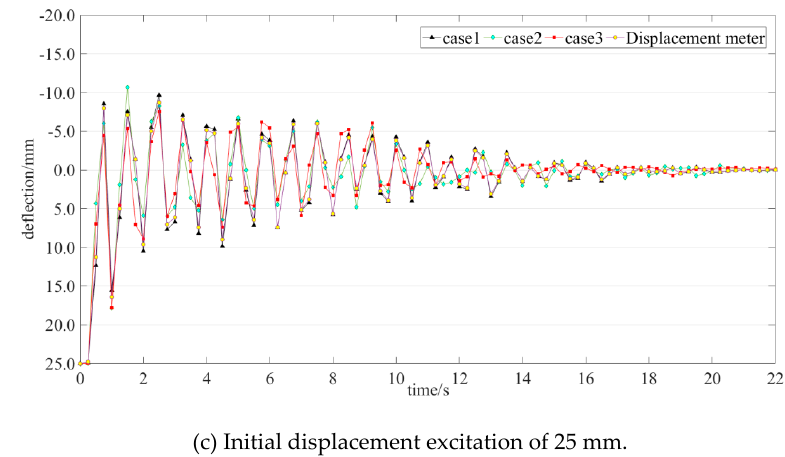
Figure 12. Deflection time history of measurement point #1 under different initial displacement excitations.